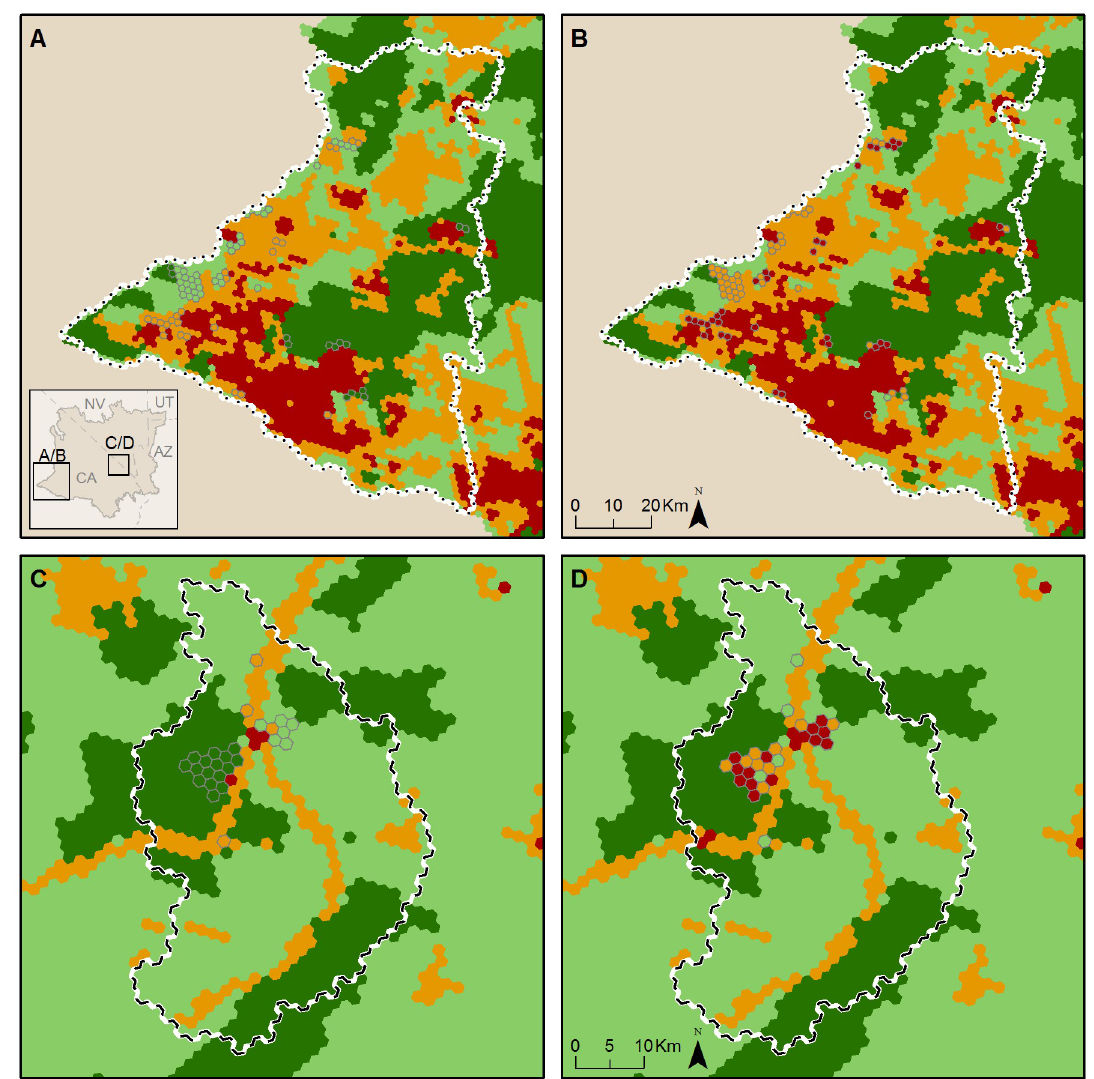
Fig 2. Comparison of conservation values. Conservation values are shown for 2009 (A and C) and 2017 (B and D) in the Western Mojave (A and B) and Ivanpah Valley (C and D) Study areas. The four colors shown on the maps (dark green, light green, orange, and red) correspond with the conservation value categories defined in Table